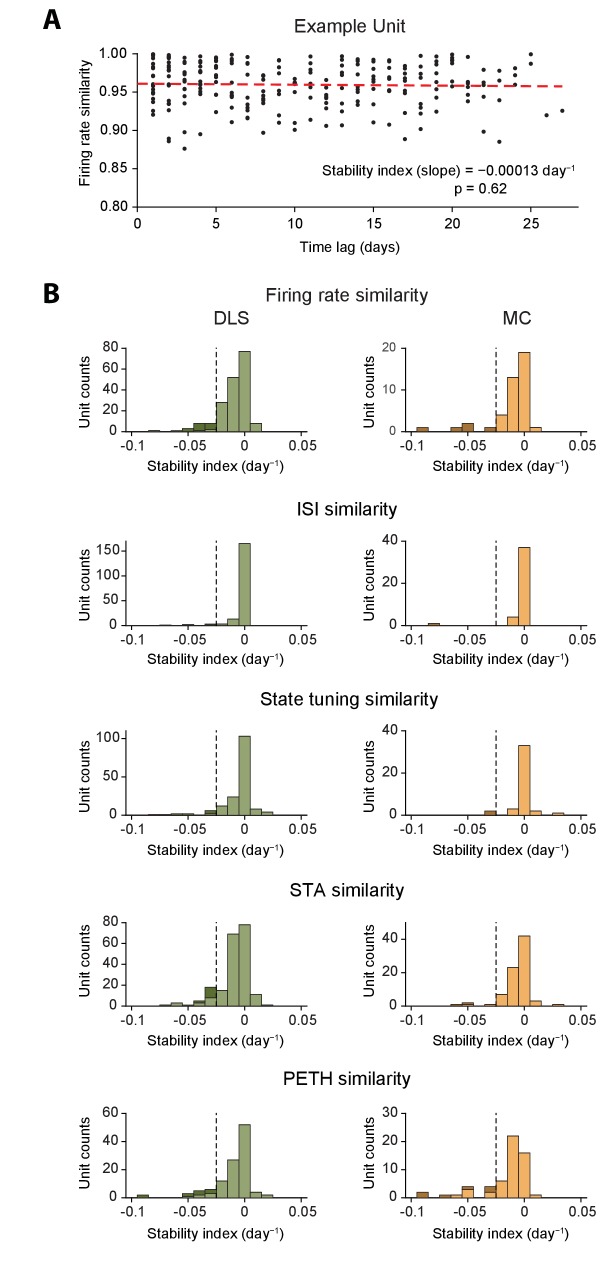
Measurements of long-term stability of neural dynamics and motor representations for individual units.(A) Measuring firing rate stability for an example unit recorded in the DLS. The plot shows firing rate similarity (see Figure 5 and Materials and methods) plotted against time-lag in days. Each dot represents a different comparison. The stability of firing rate similarity (the stability index) is measured by fitting a regression line (indicated by red dashes) to the data and calculating its slope and p-value. (B) Histograms of stability indices for different metrics of neural dynamics for all units recorded in the DLS (left) and MC (right), computed as shown in A. Shaded bars indicate counts of units with significantly low stability indices (stability index < -0.025 day−1 and p<0.05 after applying the Šidák correction for multiple comparisons). See Table 2 for quantification of the number of units with significantly low stability indices. The vertical dashed line indicates the stability threshold (0.025 day−1).